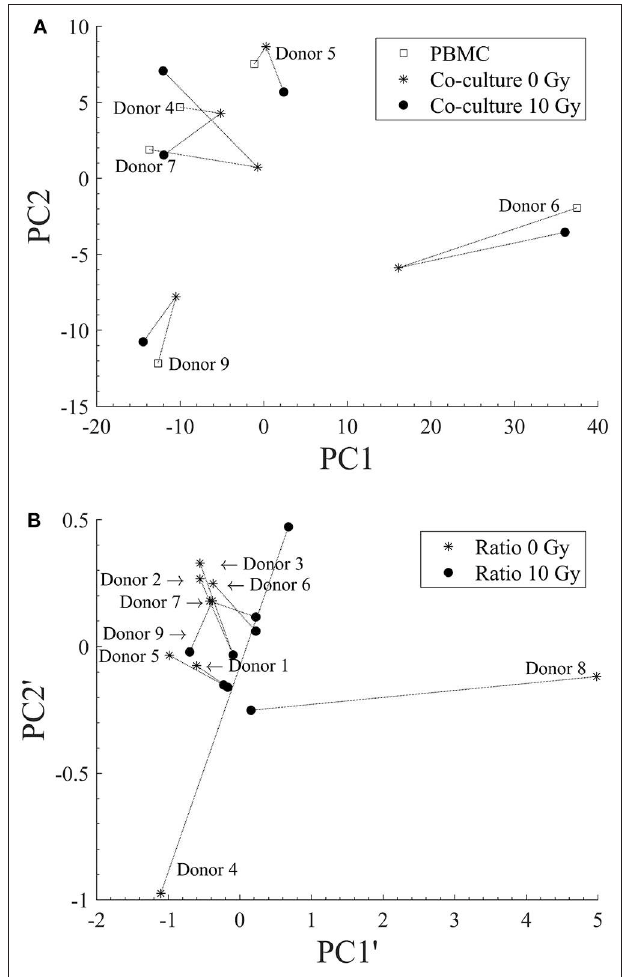
FIGURE 5 | Principal Components Analysis for discrimination of donors for different experimental conditions. (A) PCA applied to lymphocytic subsets for each individual donor for: PBMCs cultured alone (squares); PBMCs in co-culture with sham-irradiated Caco-2 (stars); and PBMCs in co-culture with 10 Gy-irradiated Caco-2 cells (filled dots). (B) PCA applied to data at a fixed 72h time point expressed as ratios between subset percentages of PBMCs when in co-culture with non-irradiated (star) or 10 Gy-irradiated Caco-2 cells (filled dots) and the same subset percentages when PBMCs are cultured alone. Dashed lines are drawn to guide the eye and connect points representing the same donors in different experimental conditions. Donors are identified by their numbers, the label is positioned close to the point representing PBMCs alone in (A) and the co-culture with non-irradiated Caco-2 cells in (B) .